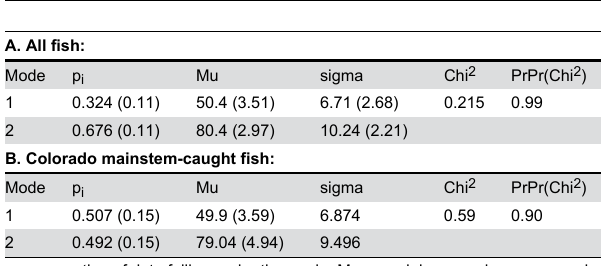
Table 3. Results of bimodal analysis of back-calculated total lengths at Age